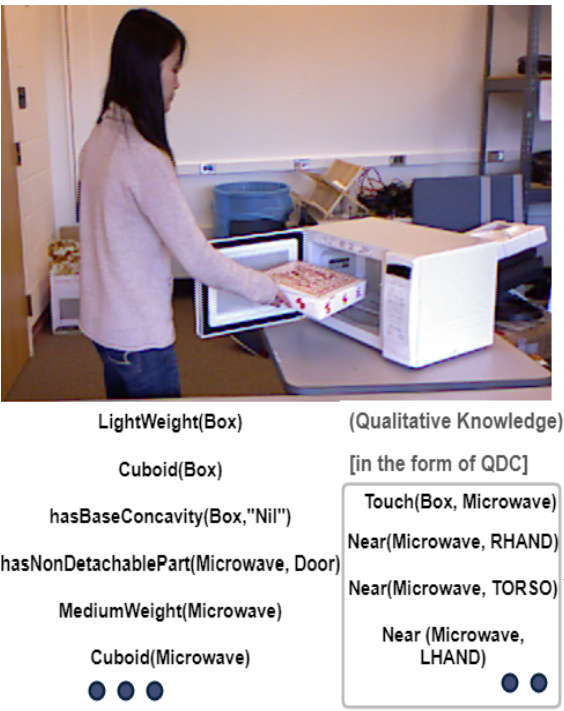
Figure 3: Grounded symbolic snapshot corresponding to the video frame (video frame is taken from CAD-120